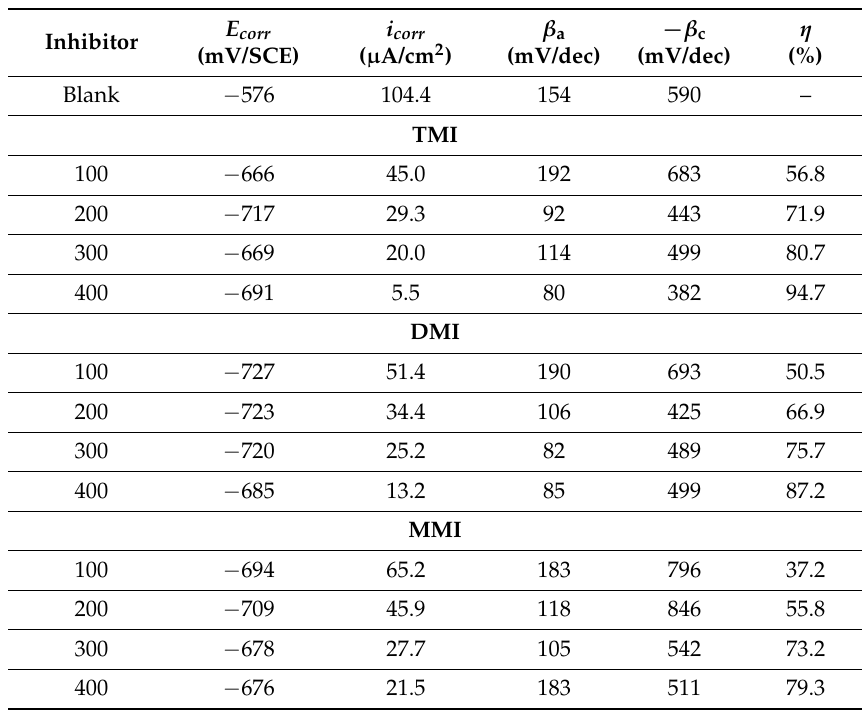
Figure 4. Potentidynamic polarization curves in absence and presence of different concentrations of inhibitors: ( a ) TMI; ( b ) DMI; ( c ) MMI. inhibitors: ( a ) TMI; ( b ) DMI; ( c ) MMI. Table 4. Electrochemical polarization parameters in the absence and presence of different concentrations of inhibitors at 308